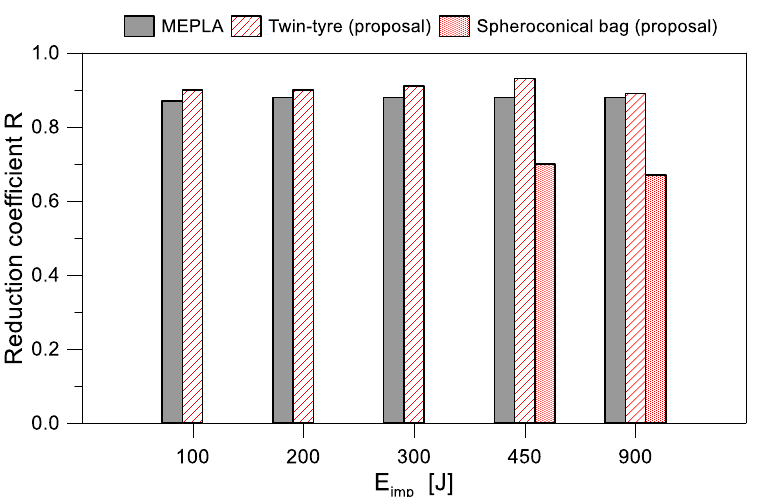
Figure 21. Calculated reduction coefficient R , as a function of impactor type and impact energy E imp (P#1). E imp